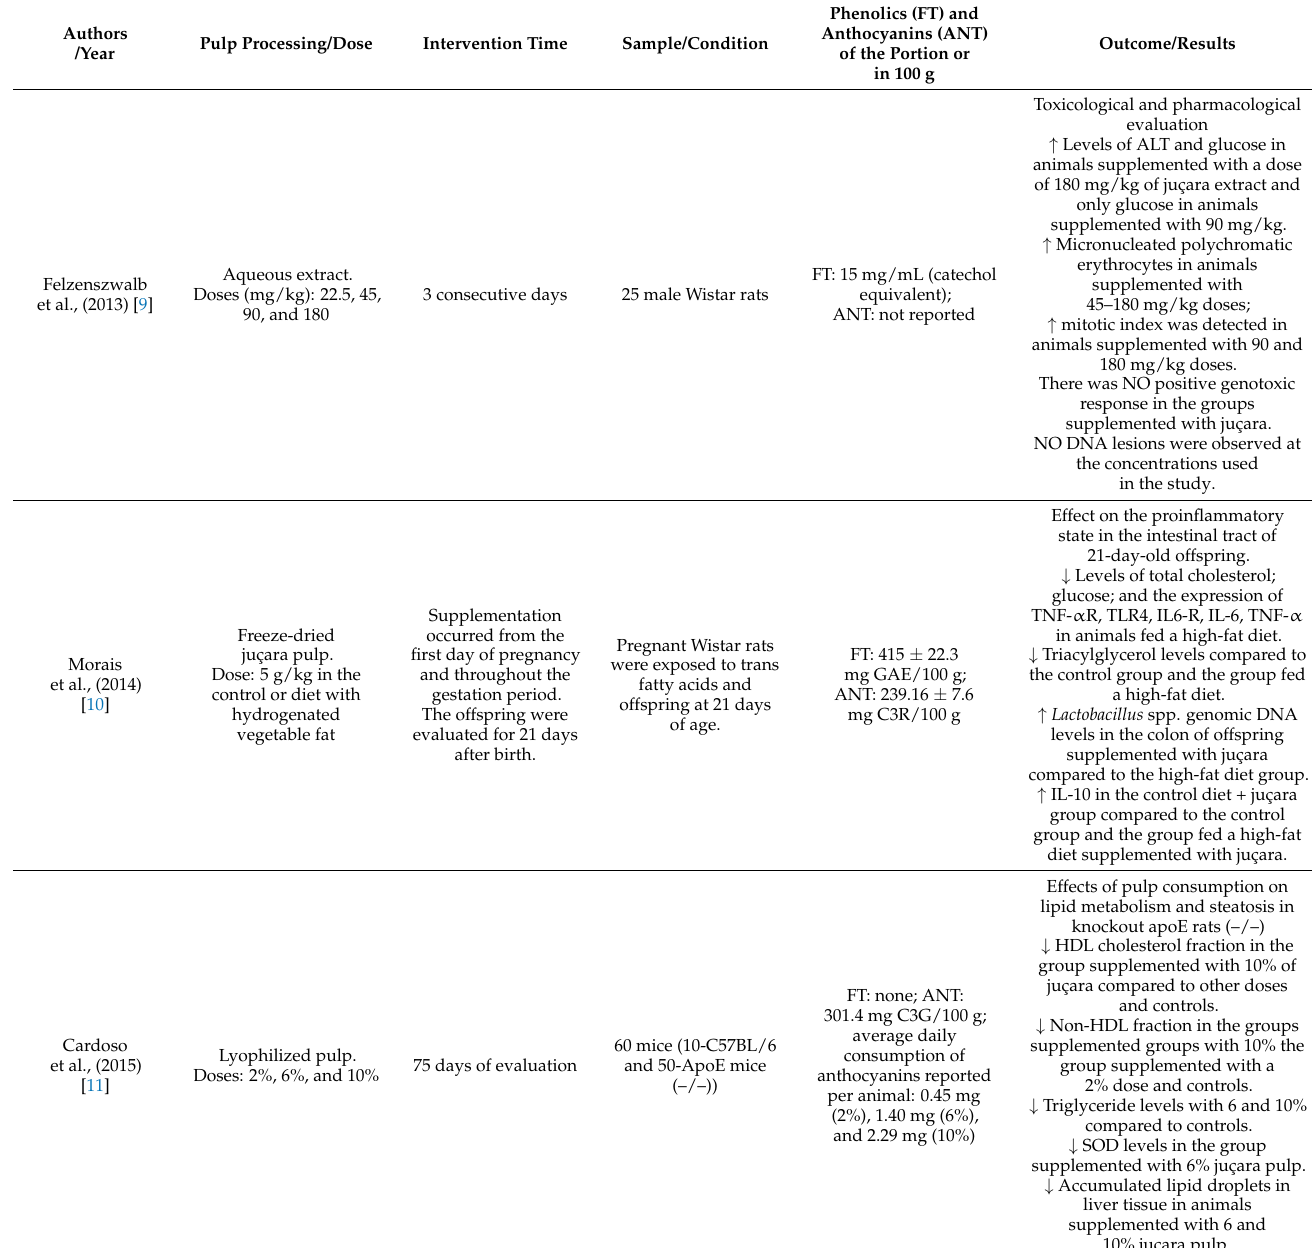
Table 1. Juçara pulp supplementation results in search of effects on preneoplastic lesions; antioxidant, nephroprotective, toxicological, prophylactic, and therapeutic effects on peptic ulcers; dyslipidemia, hepatic steatosis, glucose tolerance, genomic instability, and cell cycle progression cellular; as well as antiatherogenic and especially anti-inflammatory effects, in studies with rats, and